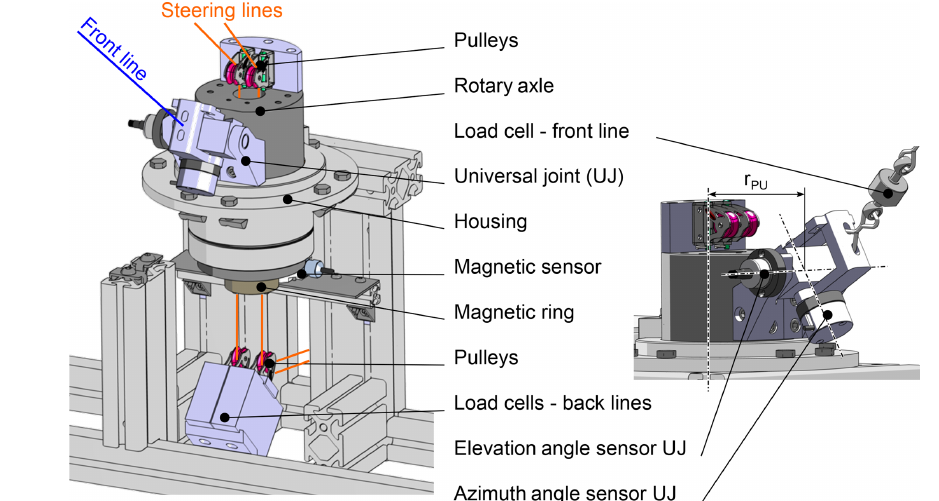
Figure 7. Design of the pivot